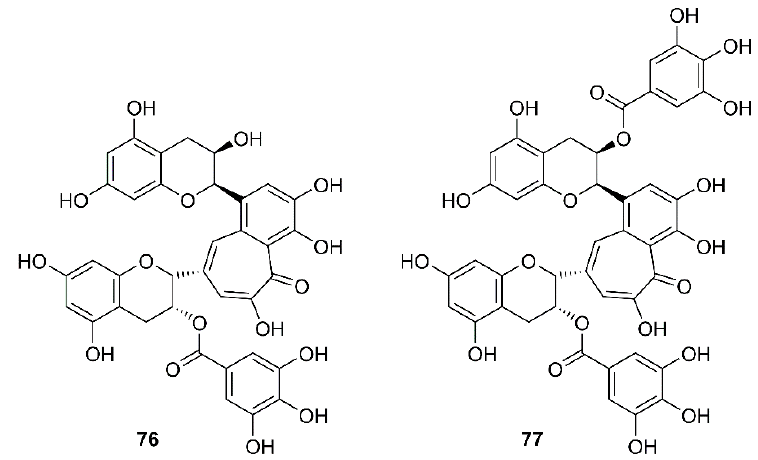
Figure 13. Structures of TF2B ( 76 ) and TF3 ( 77 ).